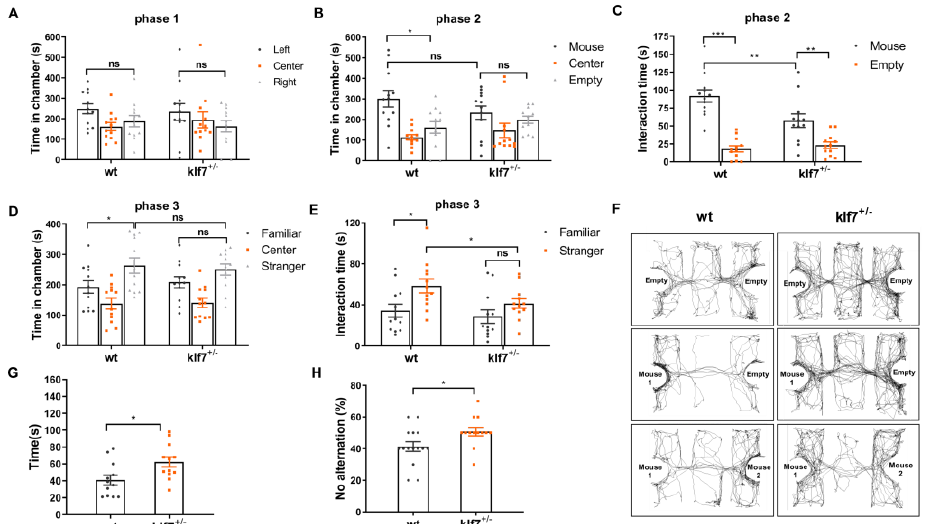
Figure 2. Loss of klf7 causes the mice to develop the core symptoms of ASD. ( A – F ) Three-chamber experiment. ( A ) All genotype mice had no preference for either of the two empty cages. ( B ) Whereas WT mice spent more time in the stranger mouse-containing caged chamber than in the empty cage- containing chamber, klf7 +/− mice had no preference for either chamber. ( C ) Klf7 +/− mice interacted with the stranger mouse for a shorter amount of time than WT mice. ( D ) Whereas WT mice spent more time in the chamber containing the novel mouse than in the chamber containing the familiar mouse, klf7 +/− mice had no preference for either chamber. ( E ) Klf7 +/− mice interacted with the novel mouse for a shorter period of time than WT mice did. ( F ) Representative tracks show the time spent in different phase of three-chambers social interaction experiment for WT mice and klf7 +/− mice. (G-H) Klf7 +/− mice exhibited stereotypical behaviors. ( G ) In the self-grooming test, klf7 +/− mice spent more time in self-grooming than WT mice. ( H ) In the Y maze spontaneous selection experiment, klf7 +/− mice preferred the original target arm, while WT mice preferred to explore the novel arm. The result is indicated by the ratio of entries into the original target arm to the entries into the novel arm in 10 trials. The data are presented as the mean ± SEM. n = 12 for WT and klf7 +/− mice. * p < 0.05, ** p < 0.01, and *** p < 0.001 by two-way ANOVA and unpaired t test; klf7, Krüppel-like transcription factor 7; ASD, autism spectrum disorder; WT, wild type.